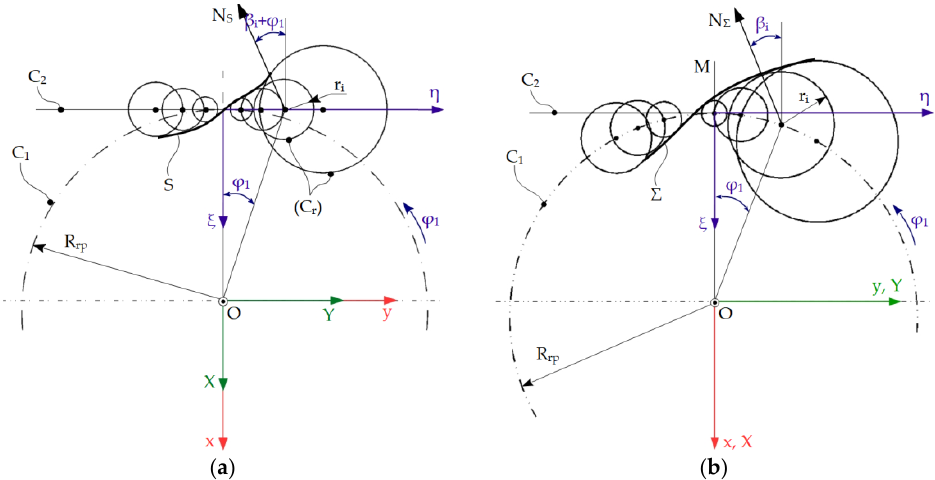
Figure 5. Family of substituting circles associated: ( a ) with a centrode; ( b ) Σ